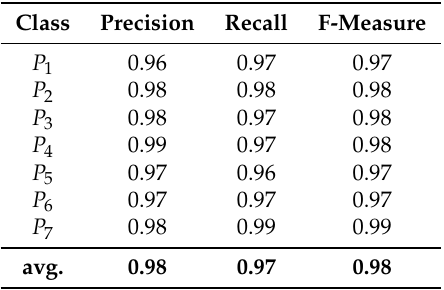
Table 8. Precision, Recall, and F-measure of proposed model for subject-dependent position detection. Class Precision Recall F-Measure P 1 0.96 0.97 0.97 0.98